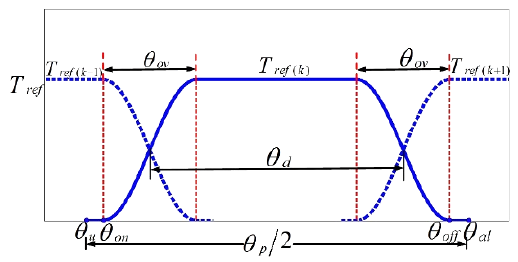
Figure 4. Illustration of a torque sharing function (TSF).